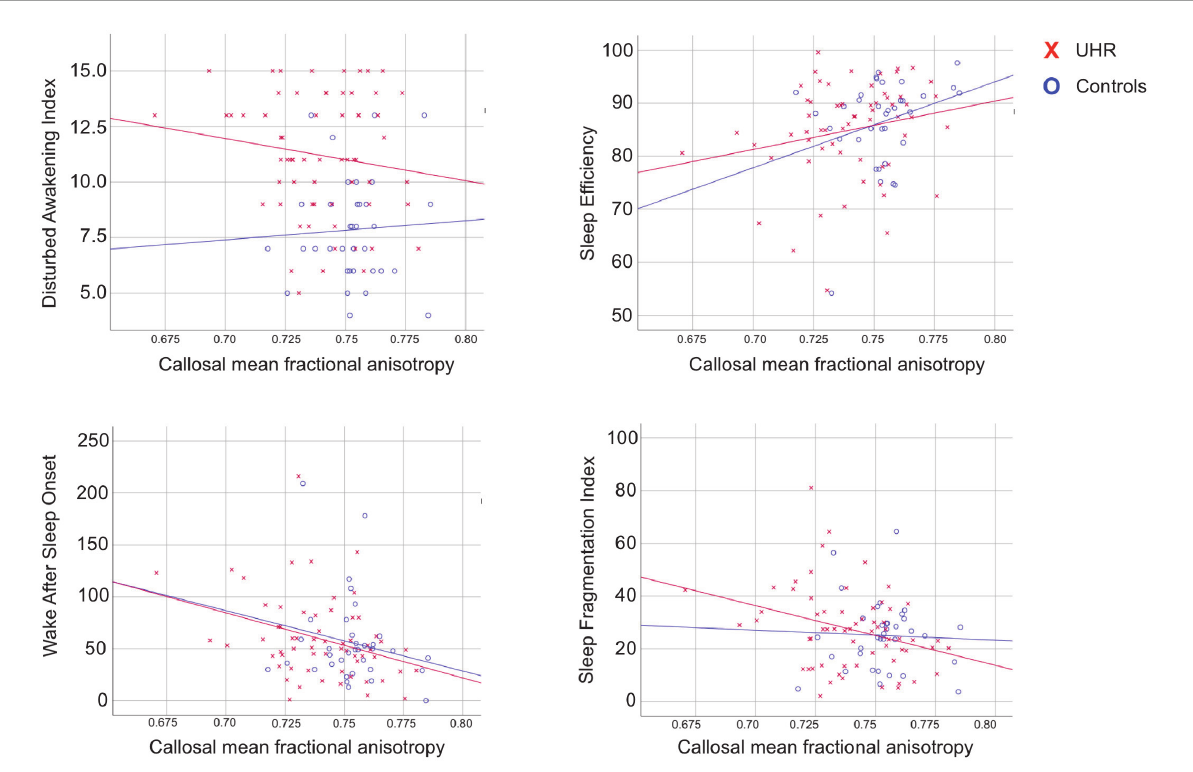
FIGURE2 Relations between callosal fractional anisotropy and sleep measures. Scatterplots illustrating the significant relations between mean callosal fractional anisotropy and sleep parameters. UHR, individuals at ultra-high risk for psychosis.